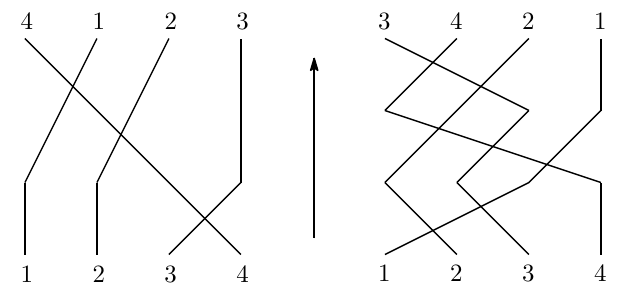
Figure 19 . Multiplication of permutations represented as diagrams, showing (123)(34) = (1234) and (123)(1234)(132) =